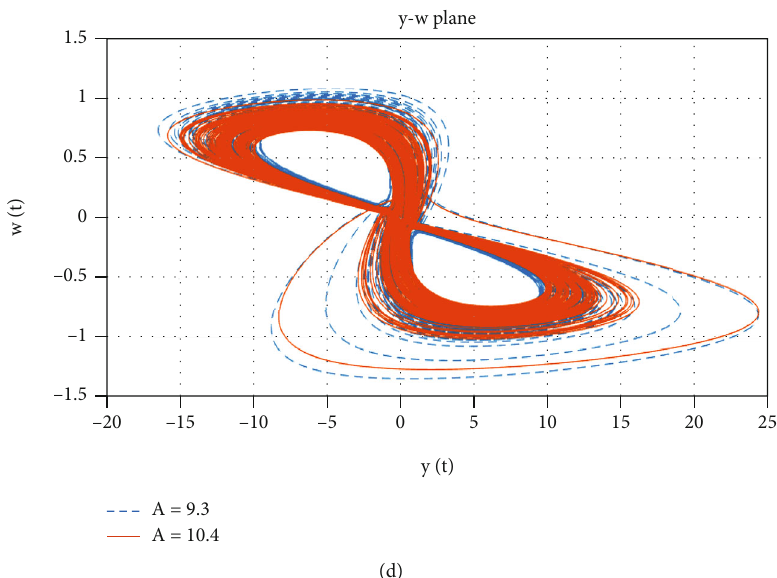
Figure 13: Attractors of the LS system (5) for di ff erent values of a in [0.5, 1] projected on: (a) x - y - z space, (b) x - w - z space, (c) z - w plane, and (d) y - w